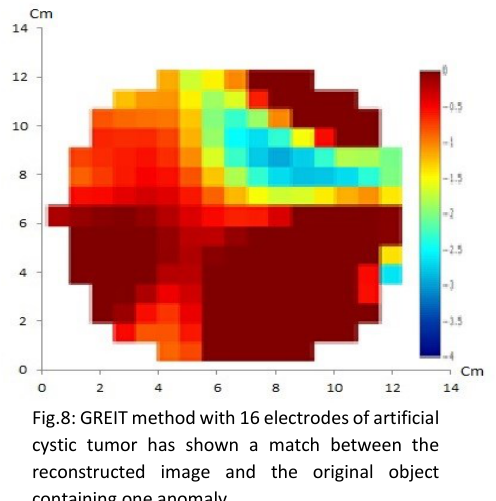
Fig.8: GREIT method with 16 electrodes of artificial cystic tumor has shown a match between the reconstructed image and the original object containing one anomaly.